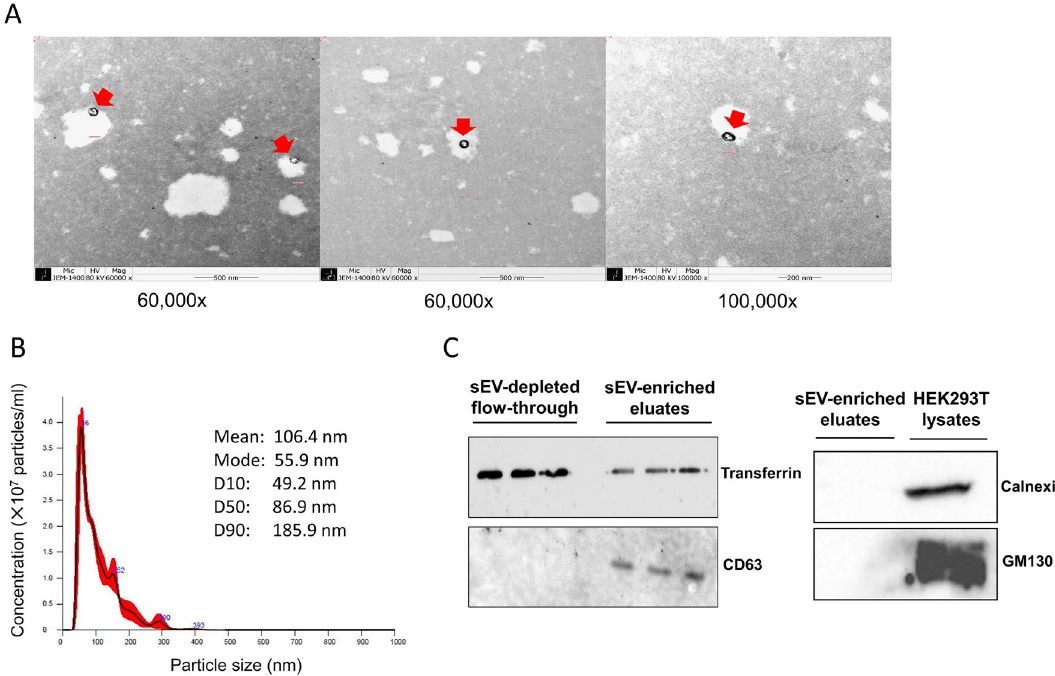
Figure 1. Characterization of serum-derived small extracellular vesicles (sEV). ( A ) Representative transmission electron microscopy (TEM) images of sEV isolated by exoEasy kit. Scale bars are 500 nm on the left and middle images (magnification × 60,000) and 200 nm on the right image (magnification × 100,000). Spherical membranous particles with an expected size of sEV are indicated with red arrows. ( B ) Representative particles size distribution profile of nanoparticle tracking analysis (NTA). The calculated size distribution is depicted as a mean (black line) with standard error (red shaded area) along with descriptive summary of particles size. The mean concentration of particles (± standard error) was 2.73 × 10 9 (5.71 × 107) particles/ml. Data were analyzed using NanoSight NTA software v3.2 (https:// www. malve rnpan alyti cal. com/ en/ suppo rt/ produ ct- suppo rt/ softw are/ nanos ight- nta- softw are- update- v3-2). ( C ) The expression of CD63 (exosome marker) and transferrin (negative marker) in sEV-enriched eluate and sEV-depleted flow-through was determined by western blotting. The expression of calnexin and GM130 (both negative markers) was also examined in sEV eluate and cell lysate (HEK293T). Full scans of all uncropped images are provided in Supplementary Fig.